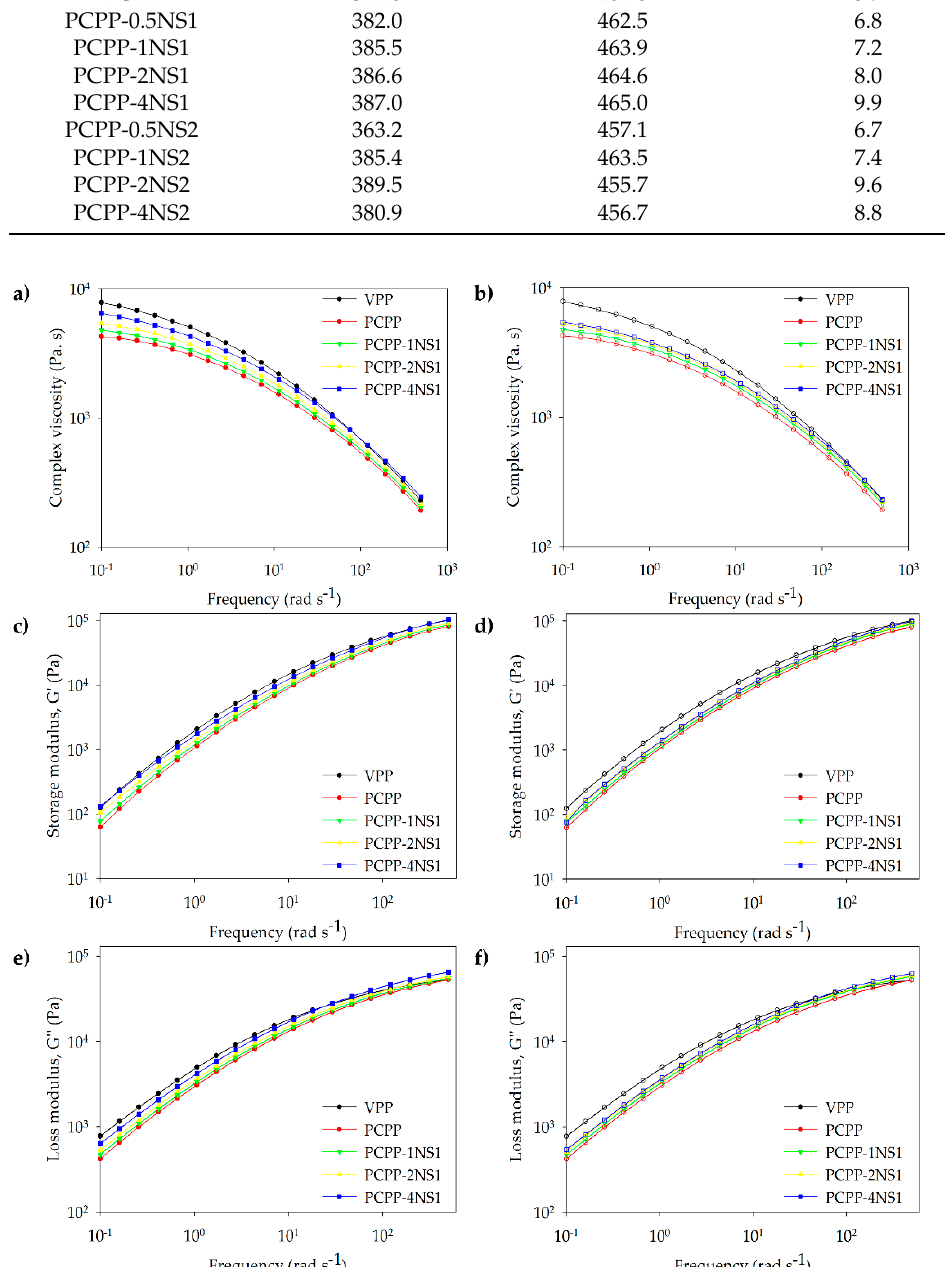
Figure 3. ( a , b ) Complex viscosity ( η *), ( c , d ) storage modulus (G ′ ) and ( e , f ) loss modulus (G ″ ) of the samples as a function of angular frequency.